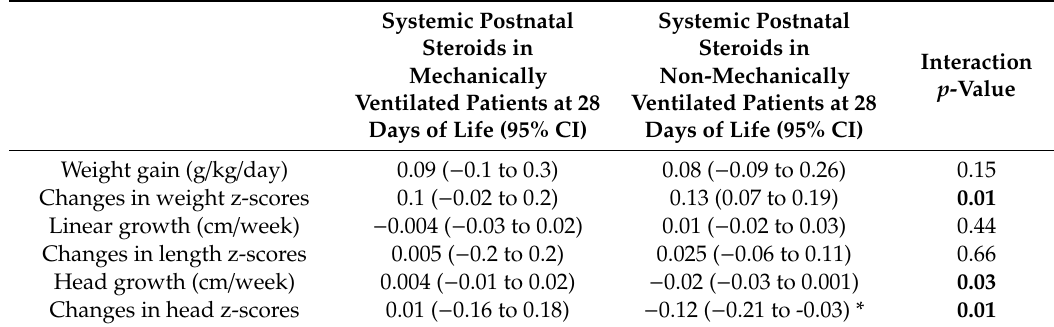
Table 3. Adjusted e ff ect of postnatal systemic steroids on the growth parameters of preterm infants < 32 weeks of gestational age stratified by ventilatory status at 28 days of life. Regression models are adjusted by GA, sex, invasive mechanical ventilation at 28 days, moderate–severe BPD, length of stay, and z-score at birth (weight, length or head circumference). Results are adjusted associations between steroids used and growth parameters (95% CI). Changes in z-scores refer to changes in z-score from birth to discharge.